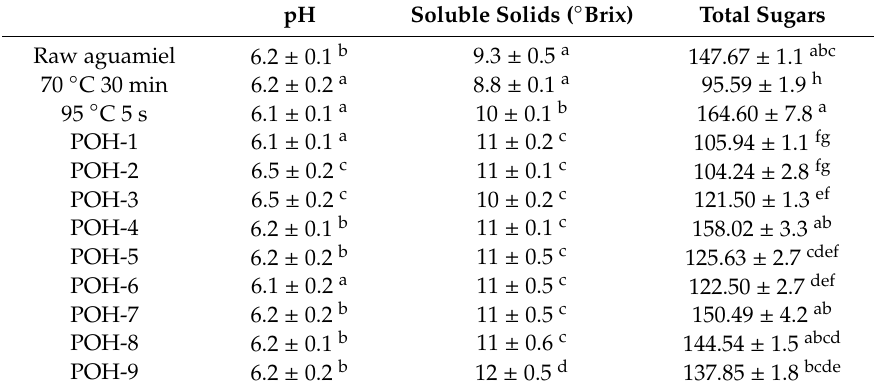
Table 3. Physicochemical analysis of raw aguamiel, conventionally pasteurized aguamiel and ohmic heating